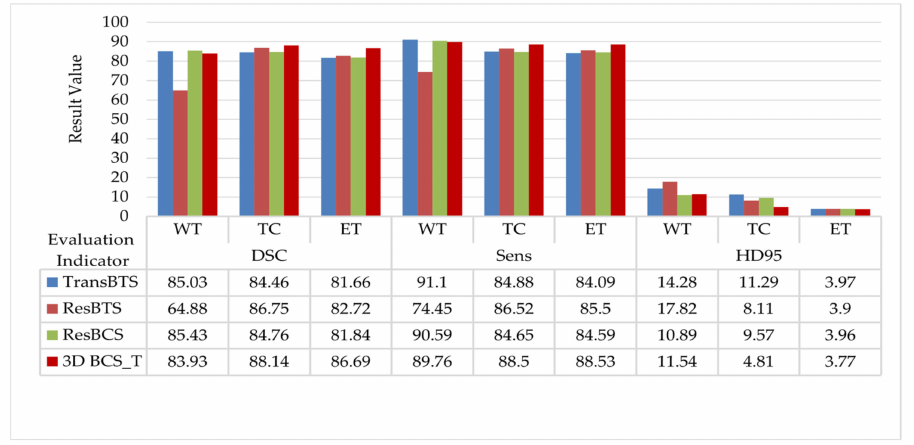
Figure 5. Comparison of the evaluation results with the different modules added to the TransBTS